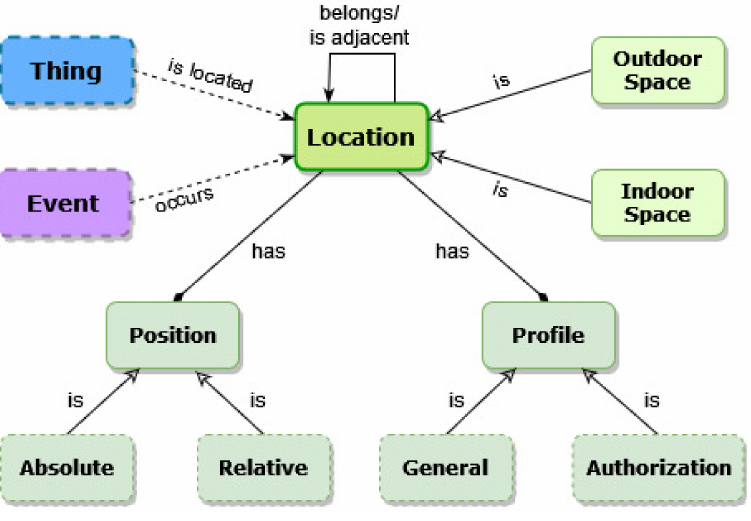
Figure 8. Location